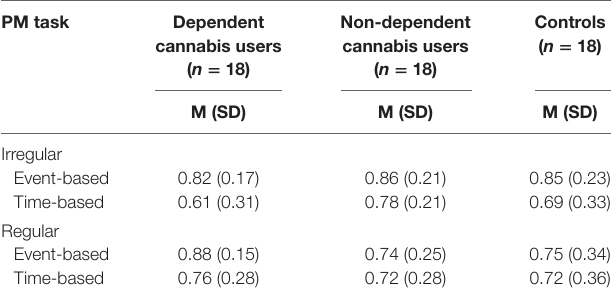
Table 5 | Comparison of dependent cannabis, non-dependent cannabis, and control groups on mean (SD) proportion of irregular and regular prospective memory (PM) tasks completed correctly in the prefuture event simulation virtual